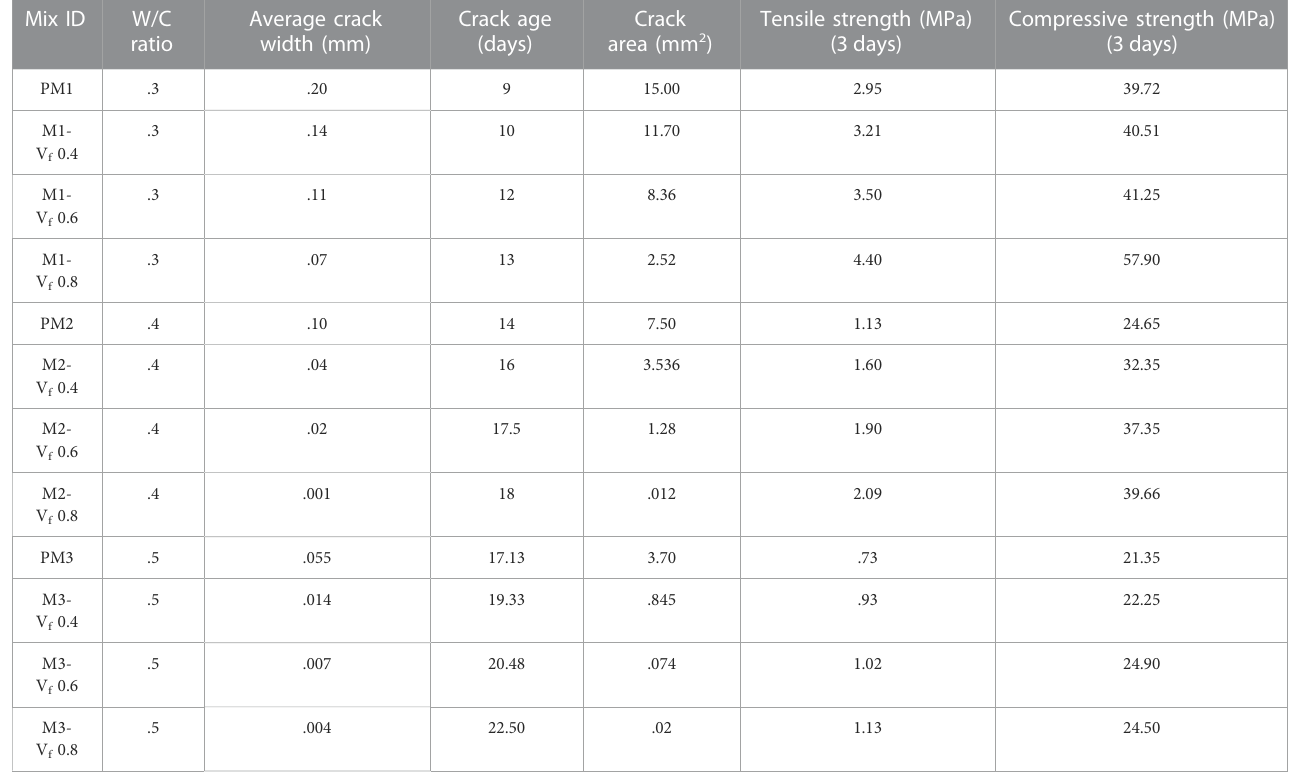
TABLE 6 Crack characteristics and mechanical properties with different fi bre fractions for mortar mixes.